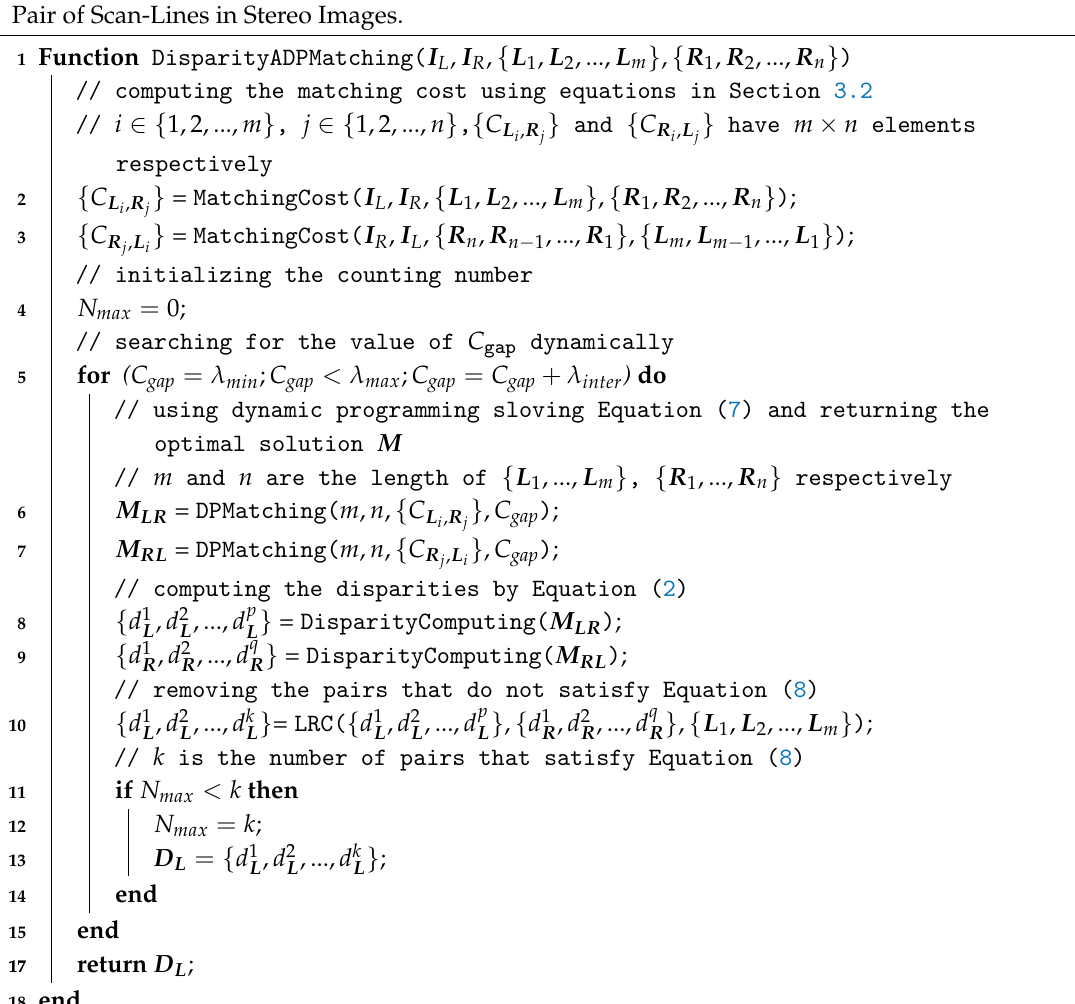
Algorithm 1: Adaptive Dynamic Programming with Disparity Consistency Constraint for Each Pair of Scan-Lines in Stereo